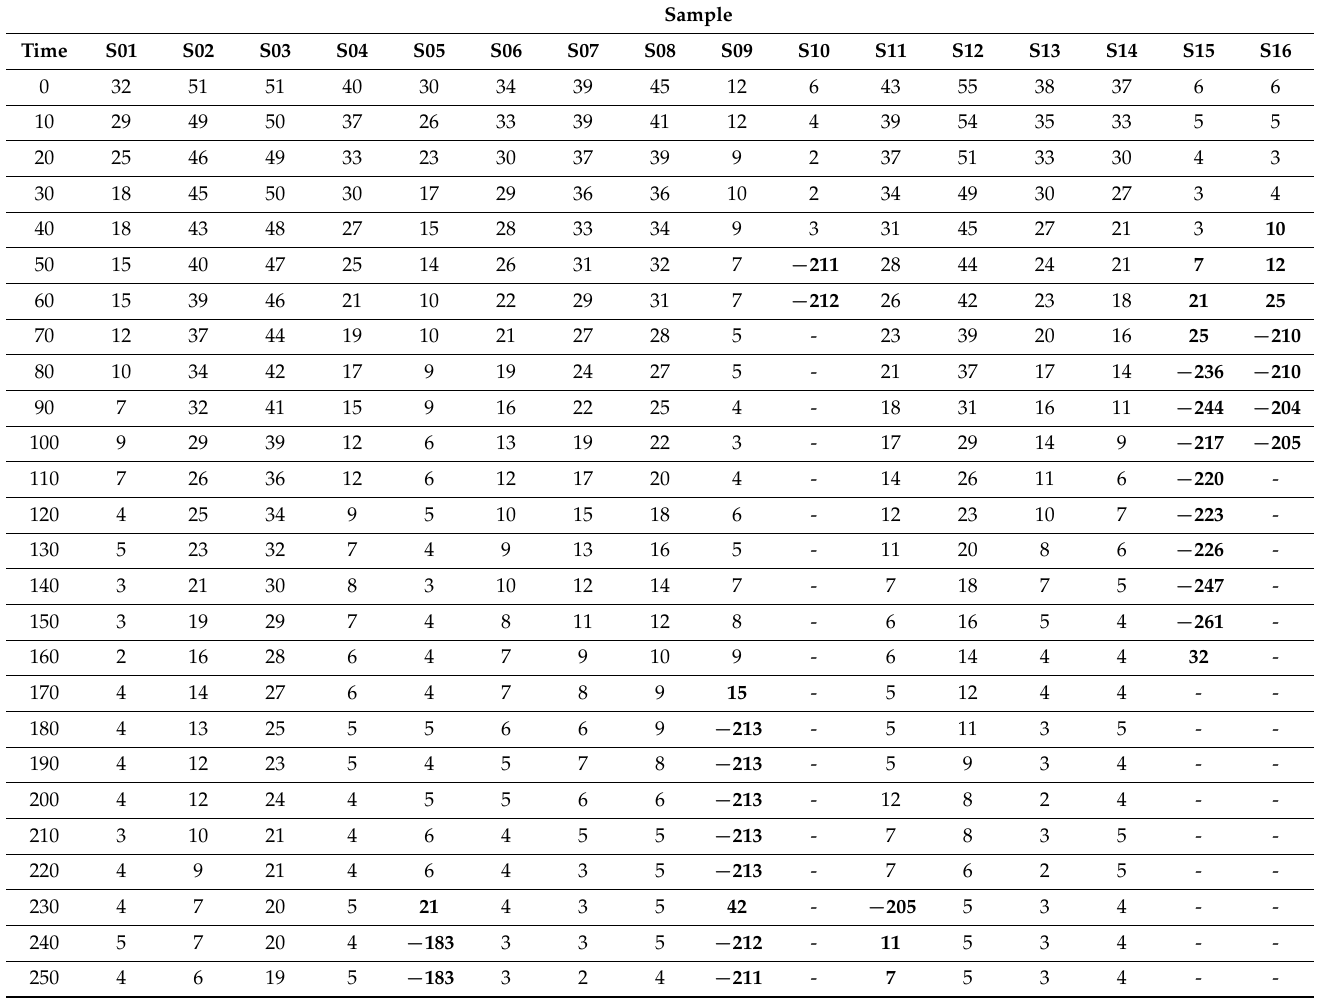
Figure 7. Graphic representation of the foam height determined by performing image analysis on RGB videos. Table 3. Height (mm) of foam of 16 beer samples determined by laser distance